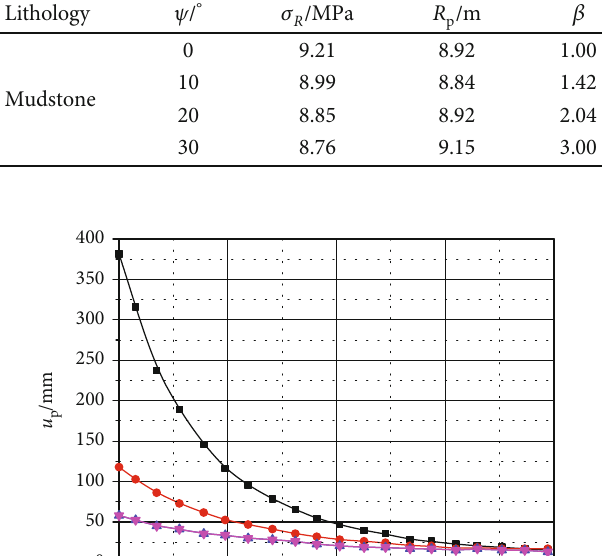
Table 2: Parameters under di ff erent dilatancy angles for mudstone. Lithology